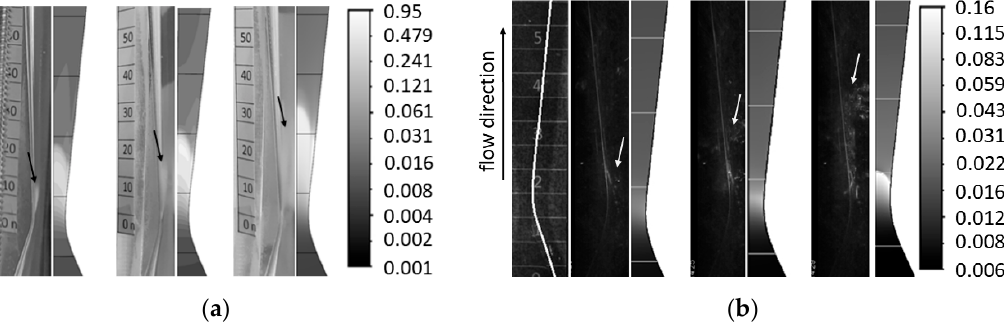
Figure 12. Comparison of cavitation cloud size, experiment on the left, numerical model on the right: ( a ) water; ( b ) oil. Figure 13a shows the cavitation cloud lengths for the evaluated variants (water and oil). The modeled cavitation cloud is overestimated for water. For oil, the modeled cavitation cloud is underestimated, see Figure